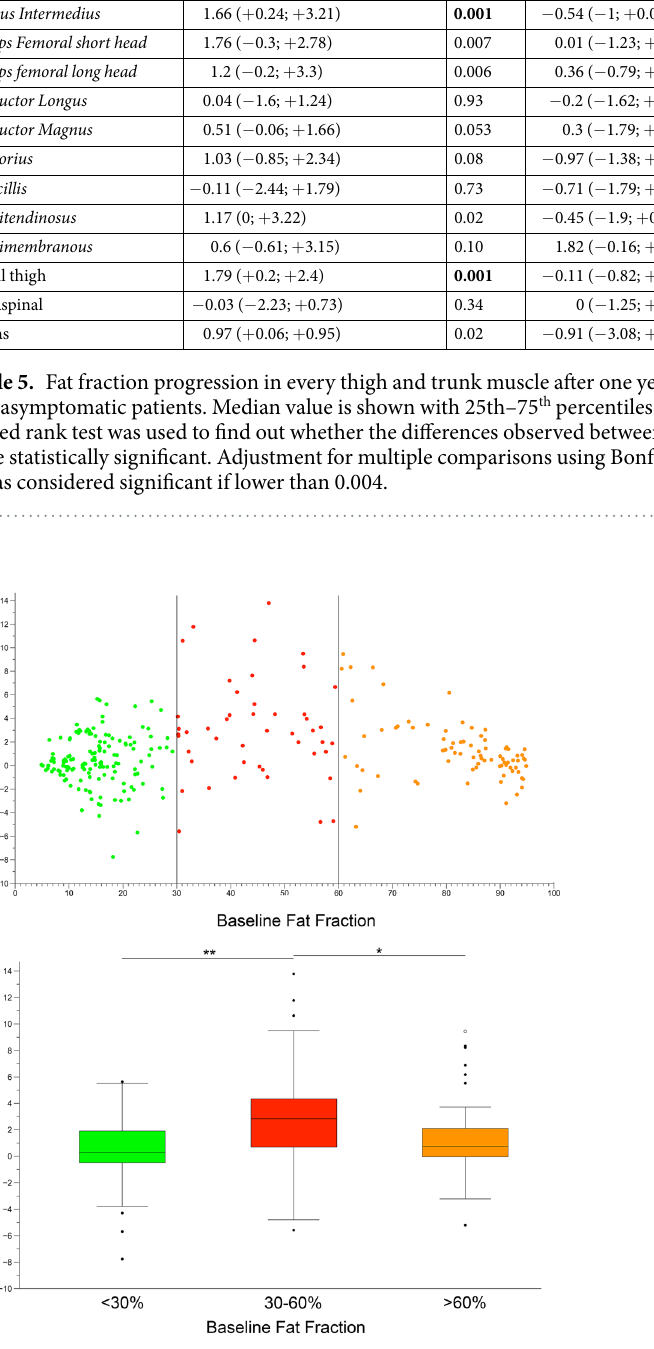
Figure 3. Yearly progression of fat replacement in individual muscles of symptomatic patients. ( A ) Each dot represents fat fraction calculated in a single muscle. Vertical lines divide muscles based on baseline fat fractions: low (green dots, 0–30%), intermediate (red dots, 30–60%) and severe (orange dots, 60–90%). ( B ) Increase in muscle fat replacement related to baseline fat fraction. The box plot includes the 25 th –75 th percentile, the mid lines indicate the median, bars correspond to the 5 th –95 th percentiles. Black dots are outliers. Kruskal-Wallis test, * P < 0.05, ** P <